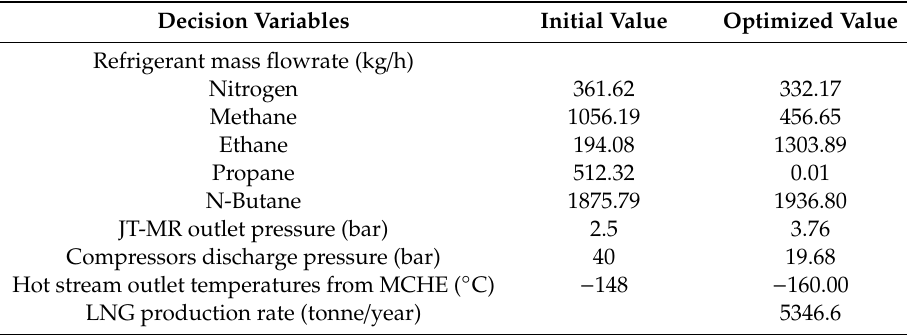
Table A4. Optimization results for single mixed refrigerant.